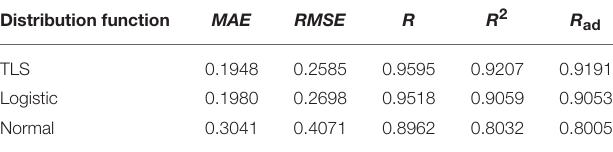
TABLE 3 | Index value of data fitting effect in Xichang City on August 9, 2018.